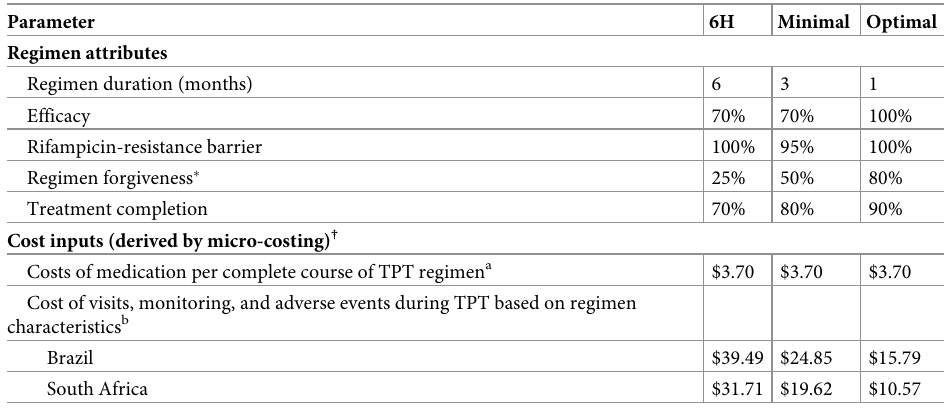
Table 1. Regimen attributes and input costs (in 2020 US